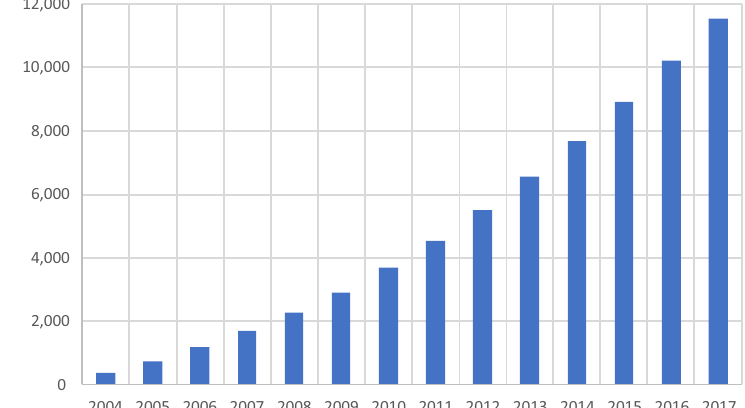
Figure 1. High-growth fi rms: number of citations in the